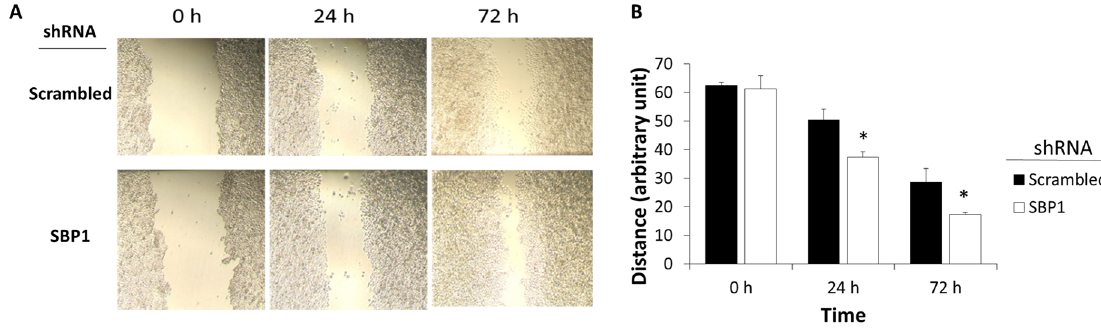
Fig 4. Knockdown of SBP1 promotes HeLa cell migration. (A) Cells cultured in DMEM supplemented with 0.2% FBS were made the wound on cell culture dishes and visualized at 0 – 72 h. (B) The wound distance was semi-quantified by randomly selecting the shortest distance between the two patches of cells. Values are means ± SEM (n = 3). * , p < 0.05, compared to scrambled shRNA